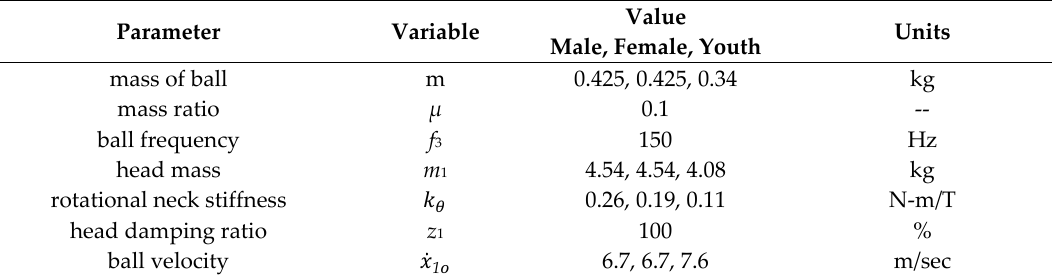
Table 1. Values for header